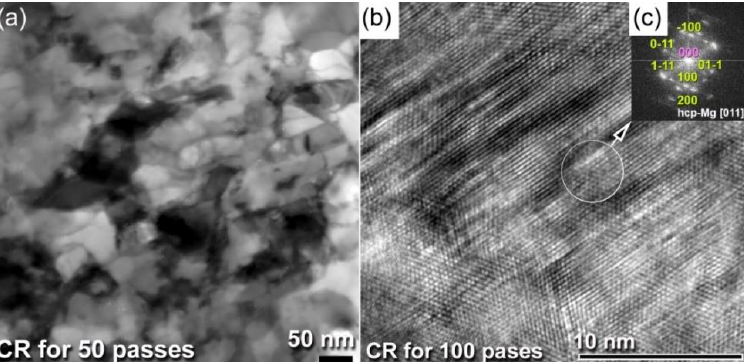
Figure 3. ( a ) BFI of Mg-rods after CR for 50 passes, ( b ) FE-HRTEM image, and ( c ) related scheme 100 passes.